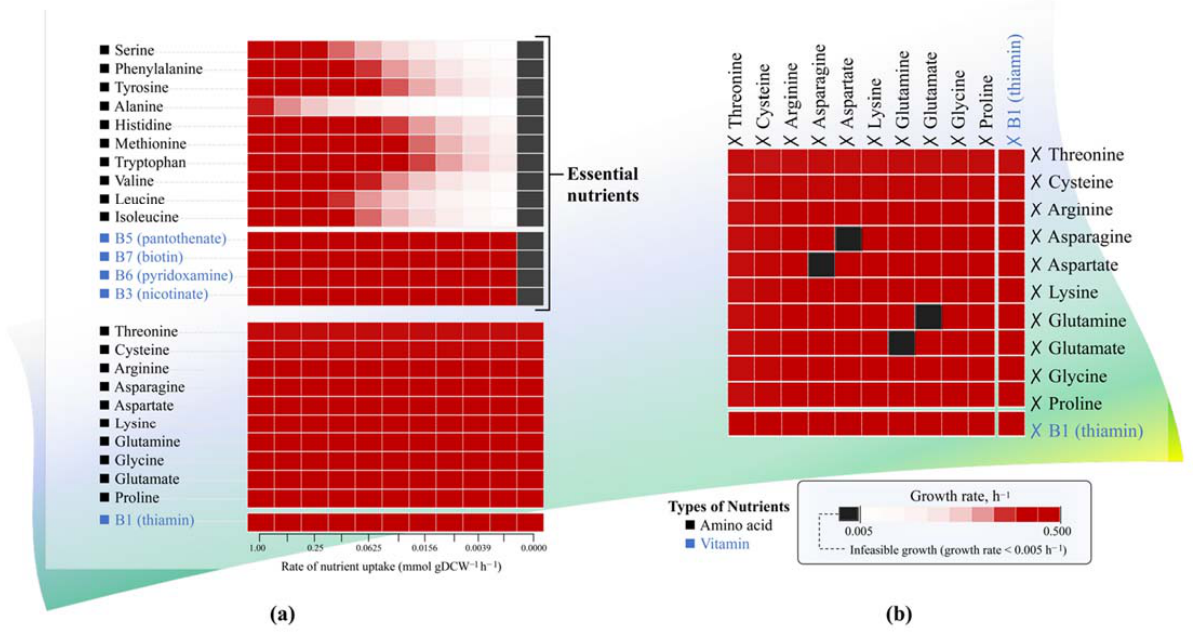
Figure 4. The identification of essential nutrients for L. reuteri KUB-AC5 growth: ( a , b ) The predicted growth behaviors of L. reuteri KUB-AC5 grown under the single omission analysis of nutrients, and under the double omission analysis of nutrients, respectively.